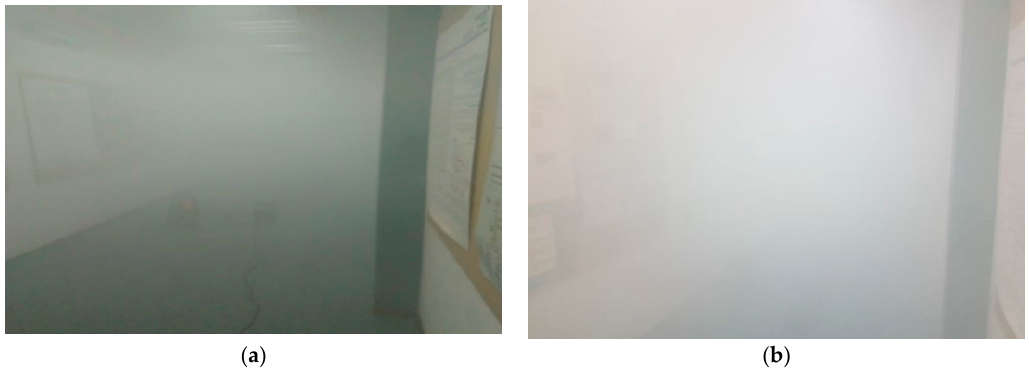
Figure 6. ( a ) The process of filling the corridor with fog, the visibility of about 1.5 m; ( b ) The corridor is filled with fog until the visibility was less than a meter.